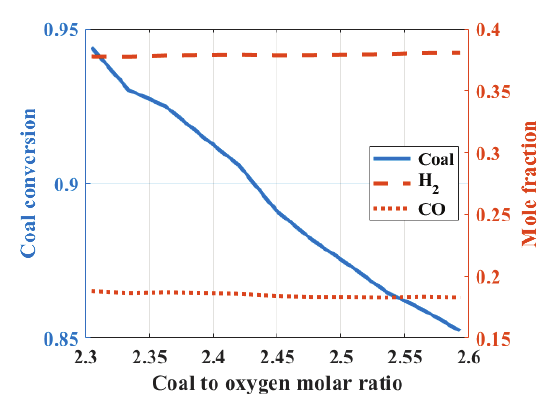
Fig. 4 – Effects of COR on outlet solid conversion and syn- thesis gas